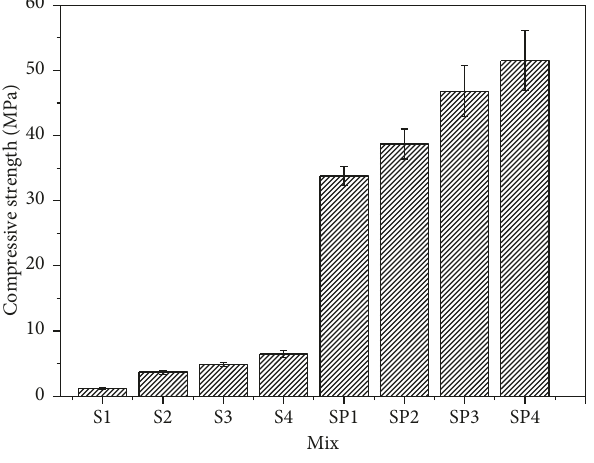
Figure 6: Strength of steel